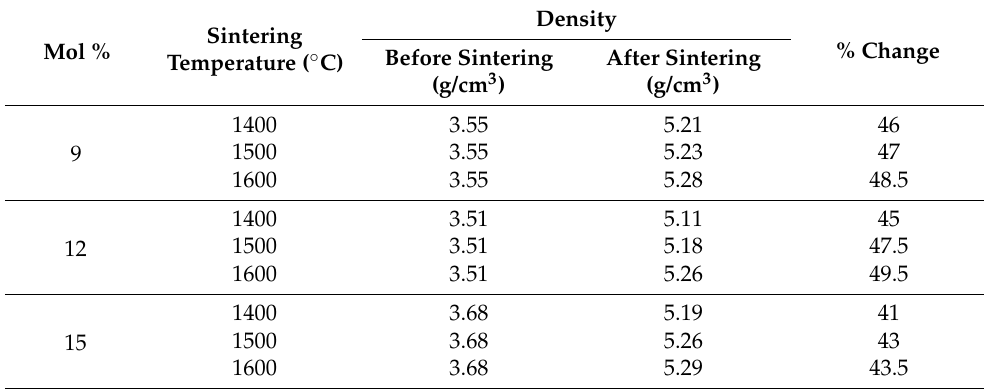
Table 3. Density measurements for Group A CSZ samples with a dwell time of 2